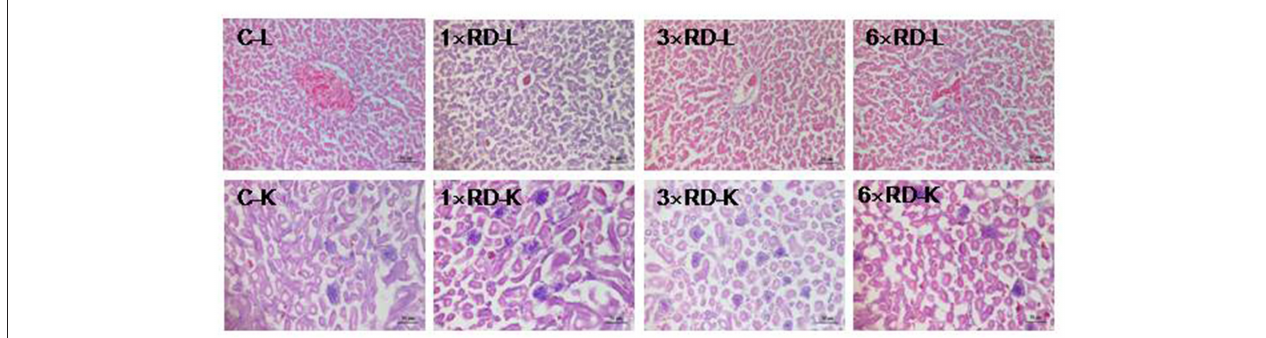
FIGURE 3 | Histopathological analysis of organs in the control (C) and three QHP-treated groups (1 × recommend dose, 1 × RD; 3 × recommend dose, 3 × RD; 6 × recommend dose, 6 × RD) after 7-day administration (H&E stained); livers (L, 100 × ); kidney (K, 100 × ). Scale bar = 50 µ m.